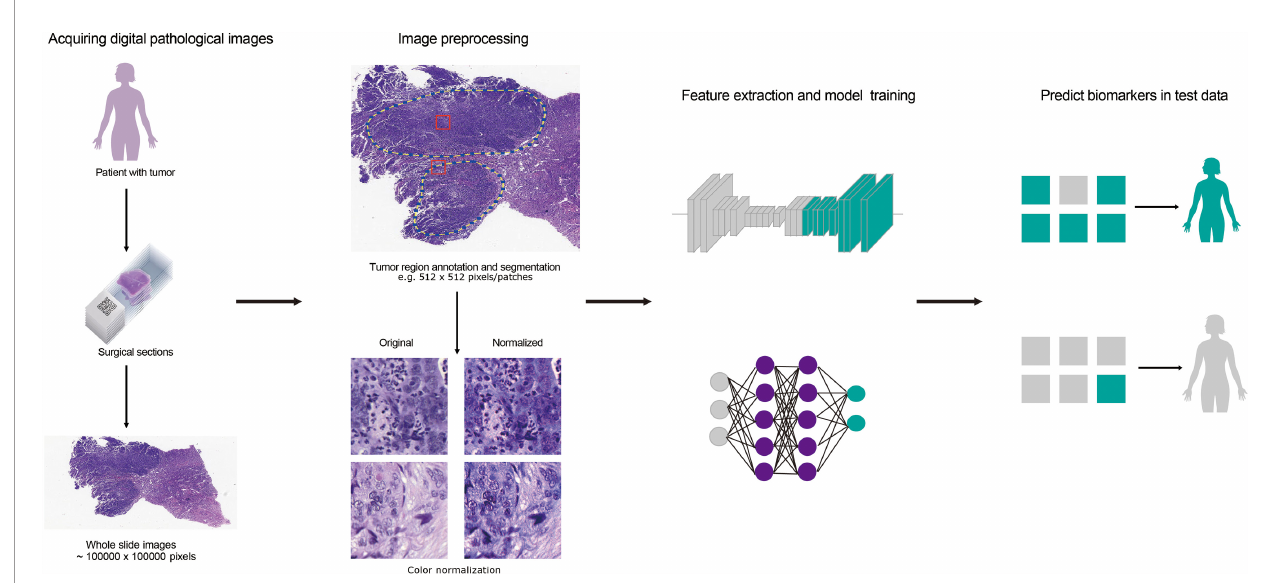
FIGURE 1 | The fl ow chart for predicting cancer-related biomarkers based on digital pathological images. Firstly, H&E stained histology slides of patients were obtained and whole slide images (WSIs) was obtained after scanning. Secondly, tumor regions were annotated by pathologists or through CNN model. Then, the regions were segmented to patches and color-normalized. Thirdly, feature extraction and model training were carried out according to biomarker labels. Finally, biomarker prediction was implemented in test